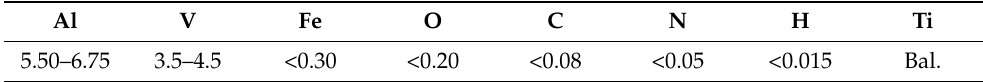
Table 1. Chemical composition of the Ti6Al4V powder (weight %), according to ASTM F2924-14 [20]. Al